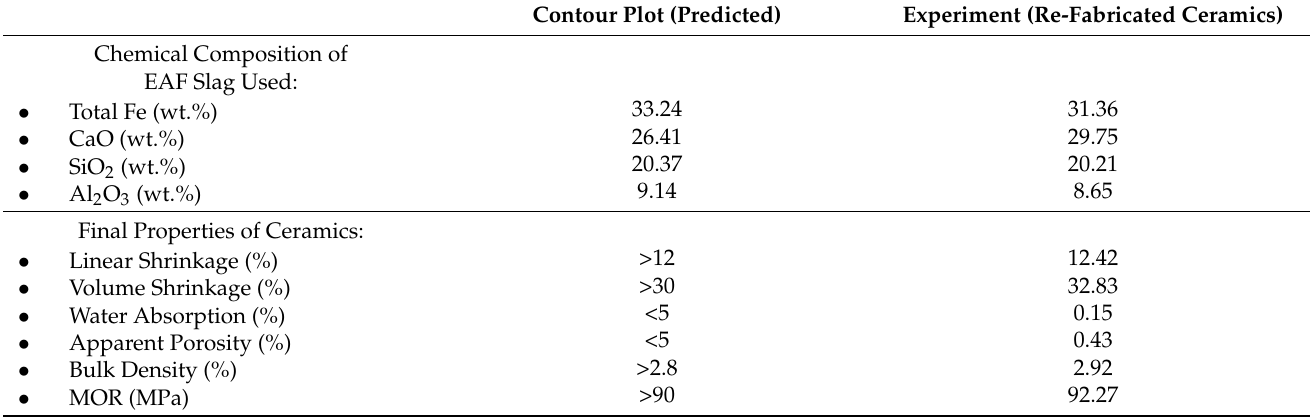
Table 6. Comparison between contour plot and re-fabricated clay-based ceramics incorporated with 50 wt.% EAF slag (coded as ‘3’) and fired at 1180 ◦ C (coded as ‘3’). Contour Plot